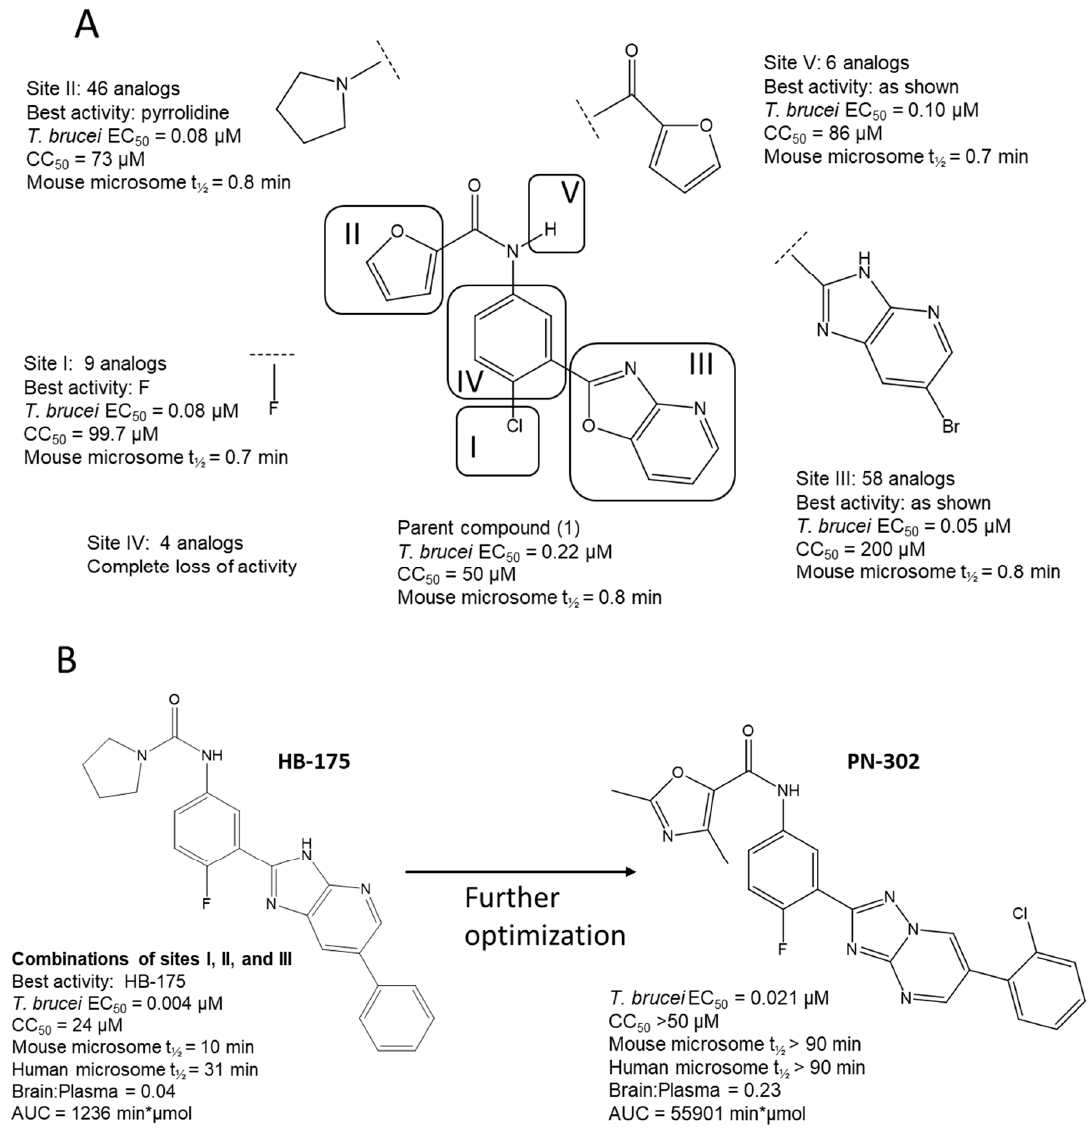
Figure 3. Optimization ( A ) and further optimization ( B ) of Scaffold 1.